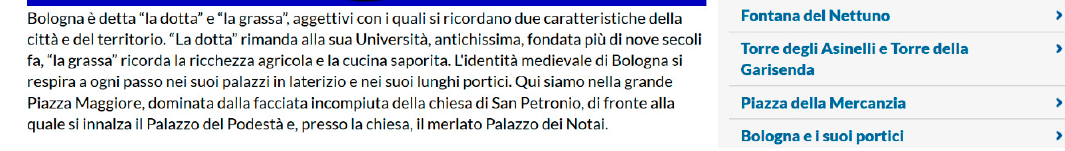
Figure 4. Example of virtual tour on the official Italian website for tourism.